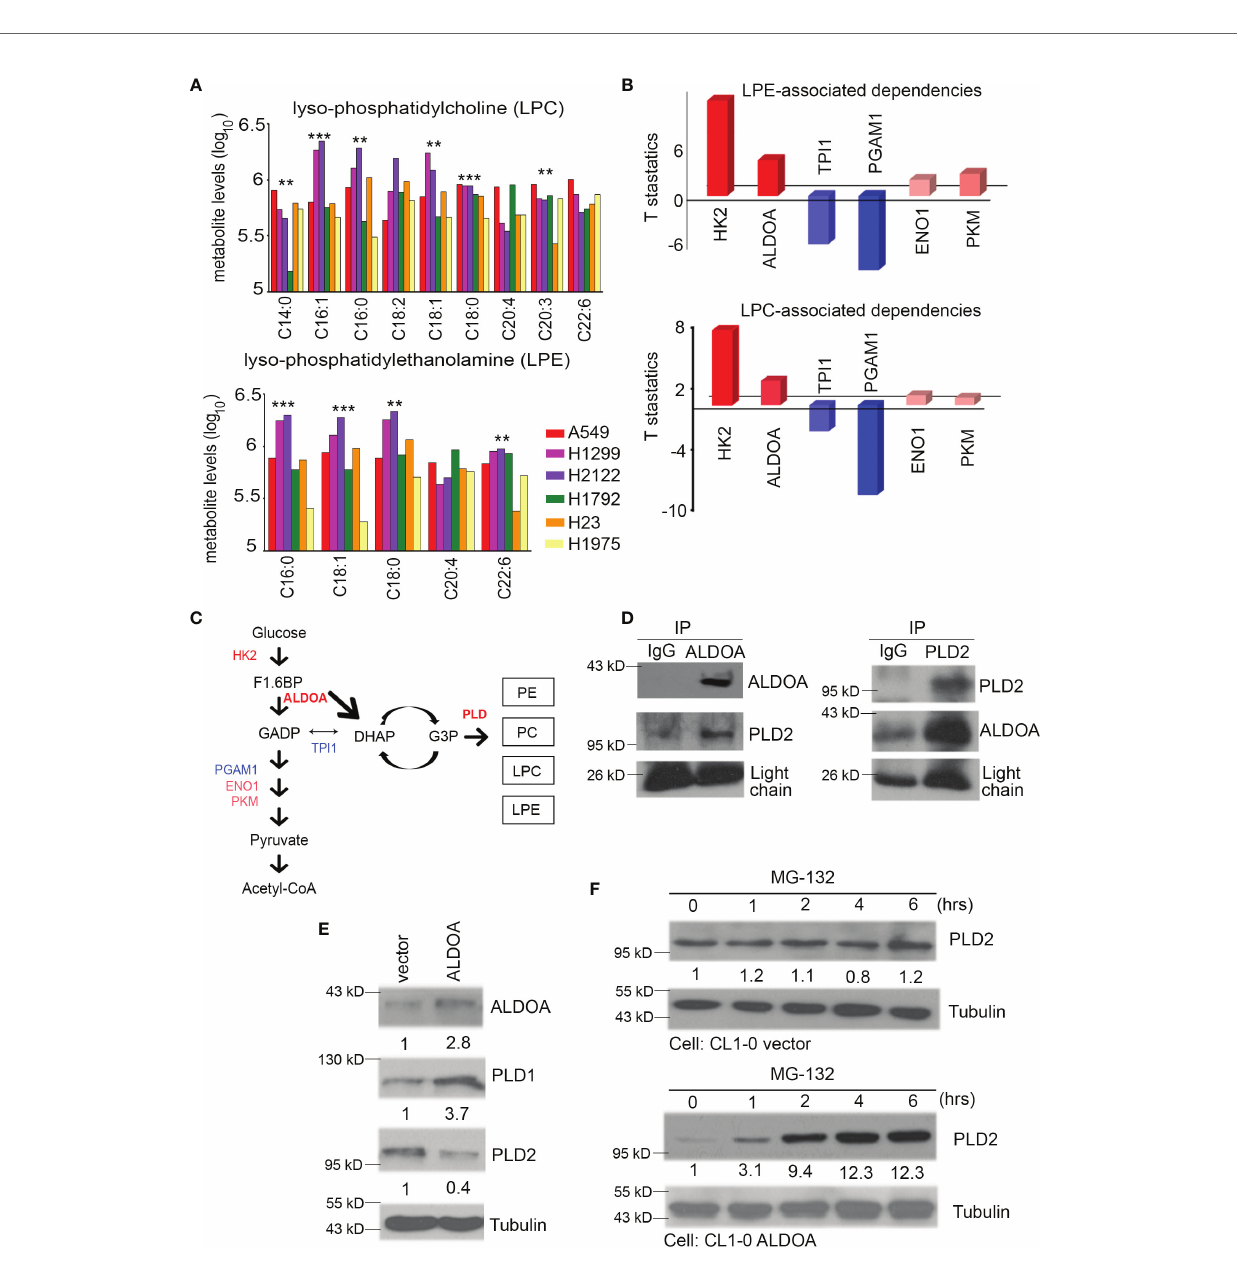
FIGURE 4 | Events and activities related to PLD depend on ALDOA. (A) The production of lysophosphatidylcholine (LPC) and lysophosphatidylethanolamine (LPE) were obtained from the available CCLE metabolomics results. Combined with previous research, we collected the survival fraction after radiation exposure in each CCLE cell. A549, H1299, H2122 (radioresistant group), and H1792, H23, H1975 (radiosensitivity group) lung cancer cells were divided into two groups to quantify their LPC and LPE concentrations. (B) The dependence of LPC or LPE products on glycolytic pathways from the available CCLE metabolites pro fi le. These con fi guration fi les are calculated based on the RNA-seq expression of each candidate in the CCLE omics database. (C) Trends between glycolysis and phospholipase D metabolic pathways. This result shows that the performance of LPC/LPE depends on HK2, ALDOA, and PLD. The importance of TPI1 has decreased. Red color means positive dependence. Blue color means negative dependence for LPC/LPE products. (D) Two-way model of immunoprecipitation using ALDOA and PLD2 antibodies in CL1-0 cells with or without forced expression of an exogenous ALDOA gene. IgG served as the negative control. (E) The protein levels of ALDOA, PLD1, and PLD2 in A549 cells with or without shALDOA. Tubulin serves as an internal control. (F) The PLD2 protein level after treatment with MG-132 is time-dependent in A549 cells with vector control or ALDOA overexpression. Tubulin serves as an internal control. The signi fi cance of the difference was analyzed using the nonparametric Mann – Whitney U